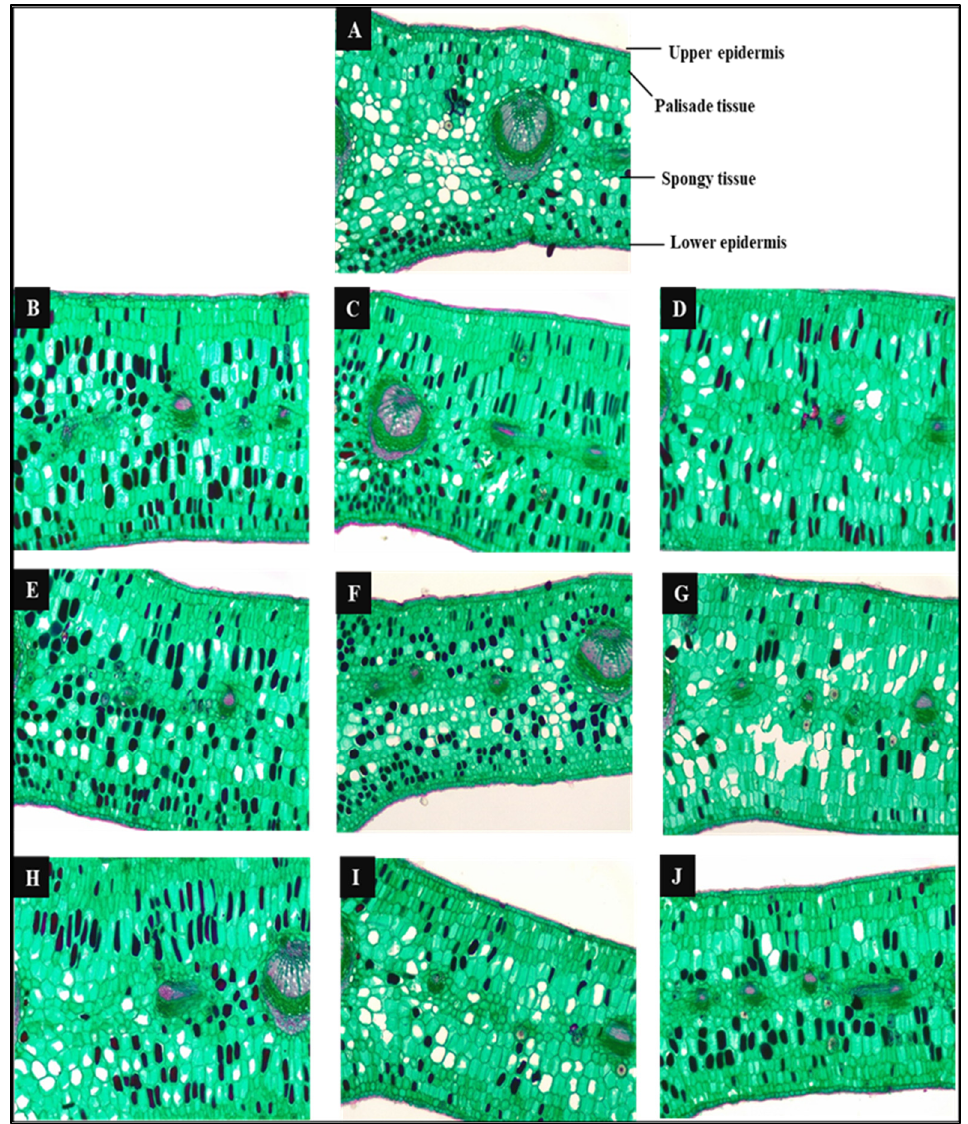
Figure 13. Microphotographs of transverse sections through the blade of leaves on the median portion of jojoba plants (135 days from the beginning of applying treatments) as affected by salinity and proline. ( A ) Control “tap water” without proline application; ( B ) 5000 ppm salinity without proline application; ( C ) 10,000 ppm salinity without proline application; ( D ) 15,000 ppm salinity without proline application; ( E ) 5000 ppm salinity with 300 ppm proline application; ( F ) 10,000 ppm salinity with 300 ppm proline application; ( G ) 15,000 ppm salinity with 300 ppm proline application; ( H ) 5000 ppm salinity with 450 ppm proline application; ( I ) 10,000 ppm salinity with 450 ppm proline application; ( J ) 15,000 ppm salinity with 450 ppm proline application. (Obj. × 10 and Oc. × 10.)